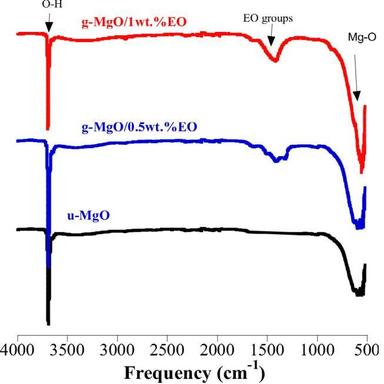
IR spectra of magnesium hydroxide nanoparticles associated with 0.5 wt% and 1 wt% essential oil from Eucalyptus globules.